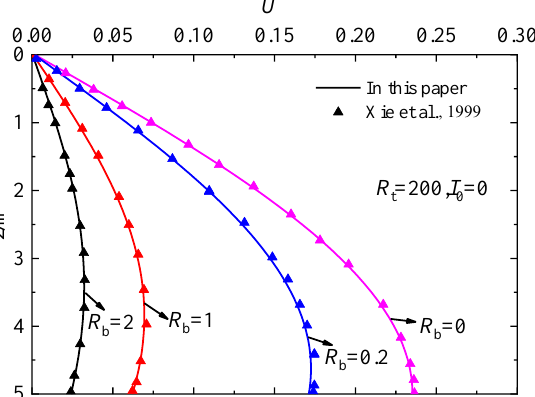
Figure 4. The verification of the double-sided impeded drainage boundaries at 500 days [9]. Figures 3 and 4 respectively show the dissipation of pore pressure along with the depth under the single-sided and double-sided impeded drainage boundaries at 500 days.